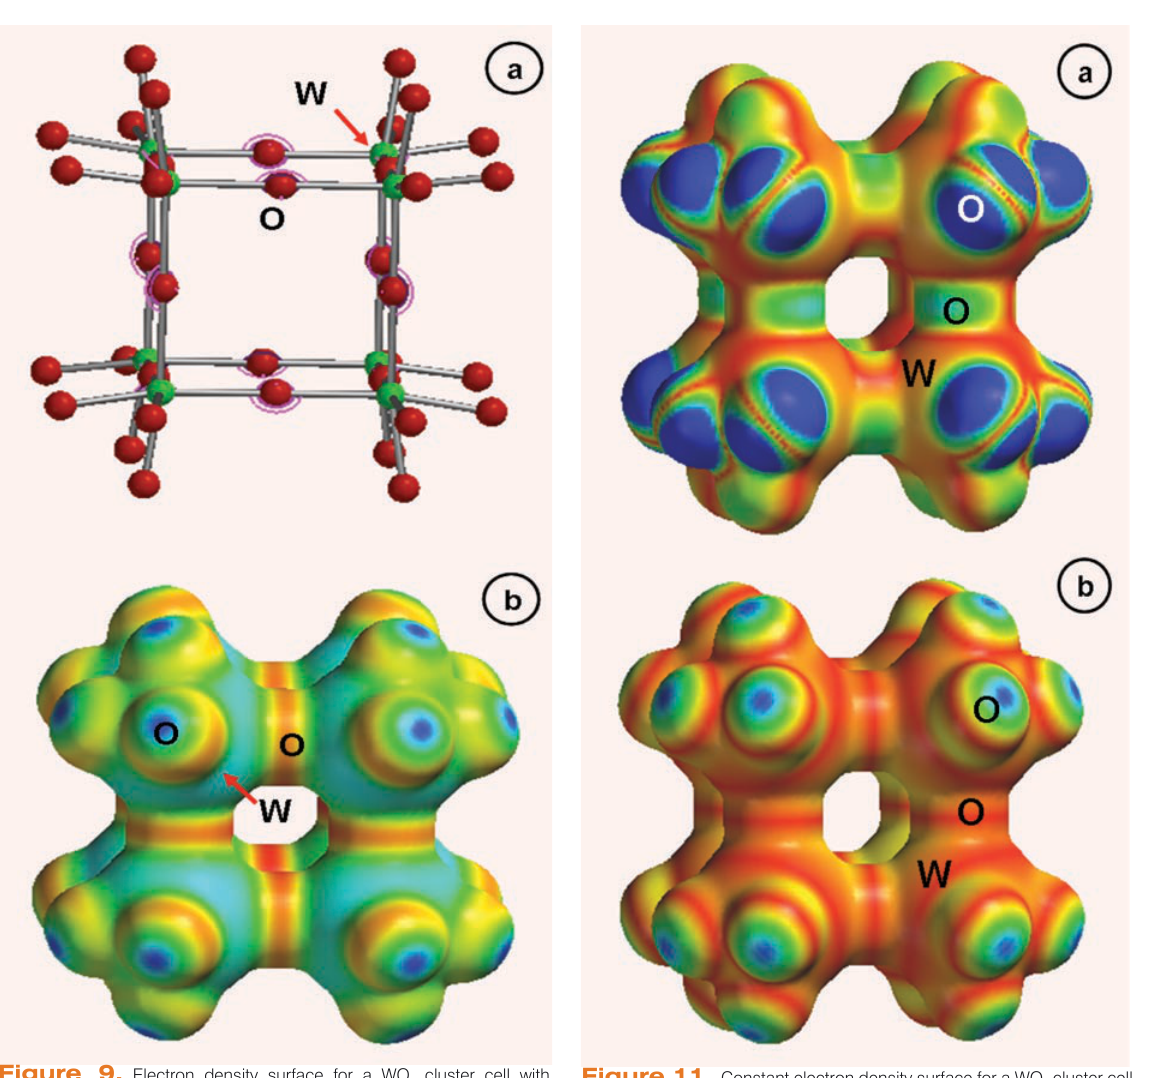
Figure 11. Constant electron density surface for a WO cluster cell with 3 with HOMO map (a) and LUMO map (b); d = 0.002.